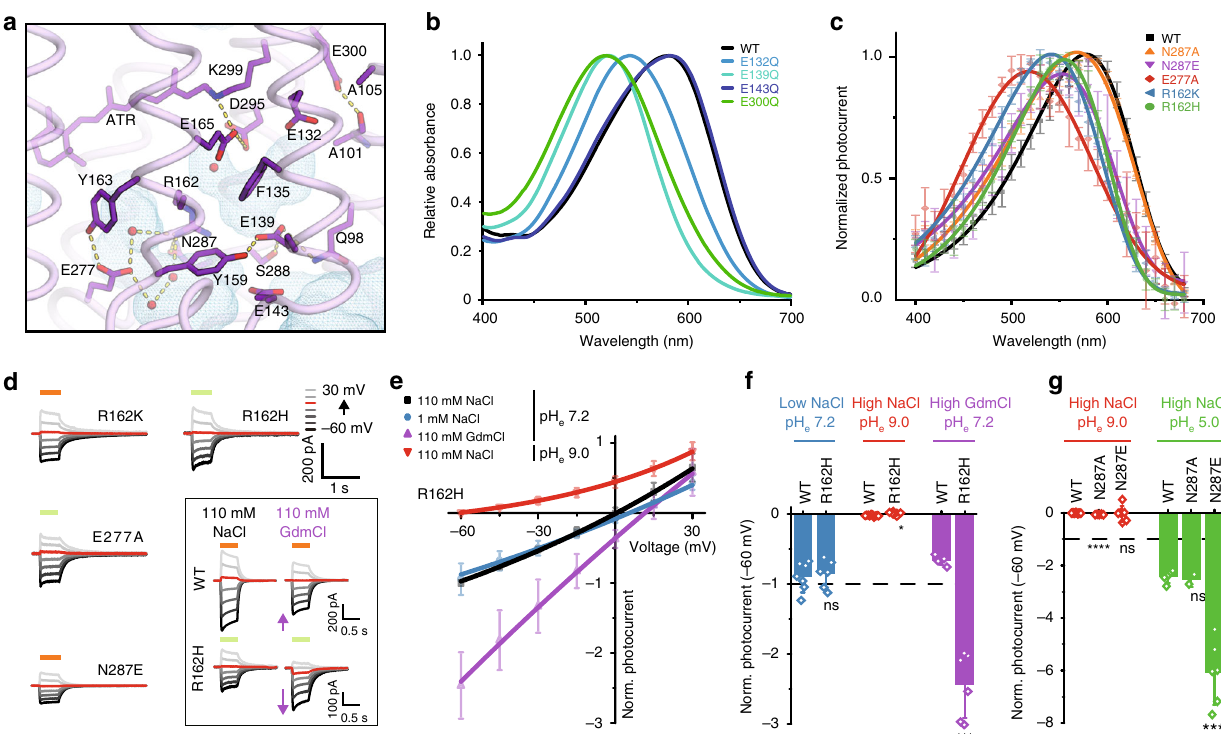
Fig. 4 Outer gate and the extracellular ion pore. a Residues around the outer gate are shown as sticks, with the interactions indicated by yellow lines. Water accessible cavities are indicated by blue meshes. b Absorption spectra of the carboxylate mutants within the extracellular ion pore and the outer gate. c Mutations in the extracellular ion pore caused blue-shifting of the action spectrum. Normalized peak photocurrents after 10 ms excitation at different wavelengths of equal photon count (Mean ± SD; n = 5 – 7; symmetric 110 mM NaCl, pH e,i 7.2 and − 60 mV) are shown. d Representative photocurrent traces of the Arg162 and Asn287 mutants at different voltages illuminated either with 550 nm light (green line) or with 580 nm light (orange line) depending on peak absorption. The inset shows representative photocurrent traces of wild type (upper) and R162H (bottom) upon replacement of Na + with guanidinium. The purple arrows indicate the photocurrent increase or decrease upon cation exchange in the R162H mutant and Chrimson WT, respectively. e Current-voltage dependence of normalized R162H photocurrents in extracellular solutions of different cation or proton composition (mean